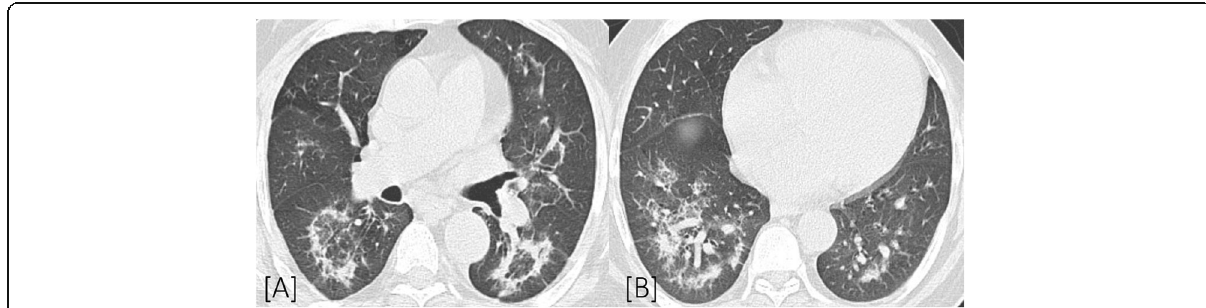
Fig. 5 A 42-year-old patient with active hepatitis, normal PFT complaining from progressive dyspnea following therapy. a , b Axial HRCT chest (lung window) showing bilateral patchy areas of air trapping admixed with GGO “ head cheese pattern ” without appreciable reticular changes. COP